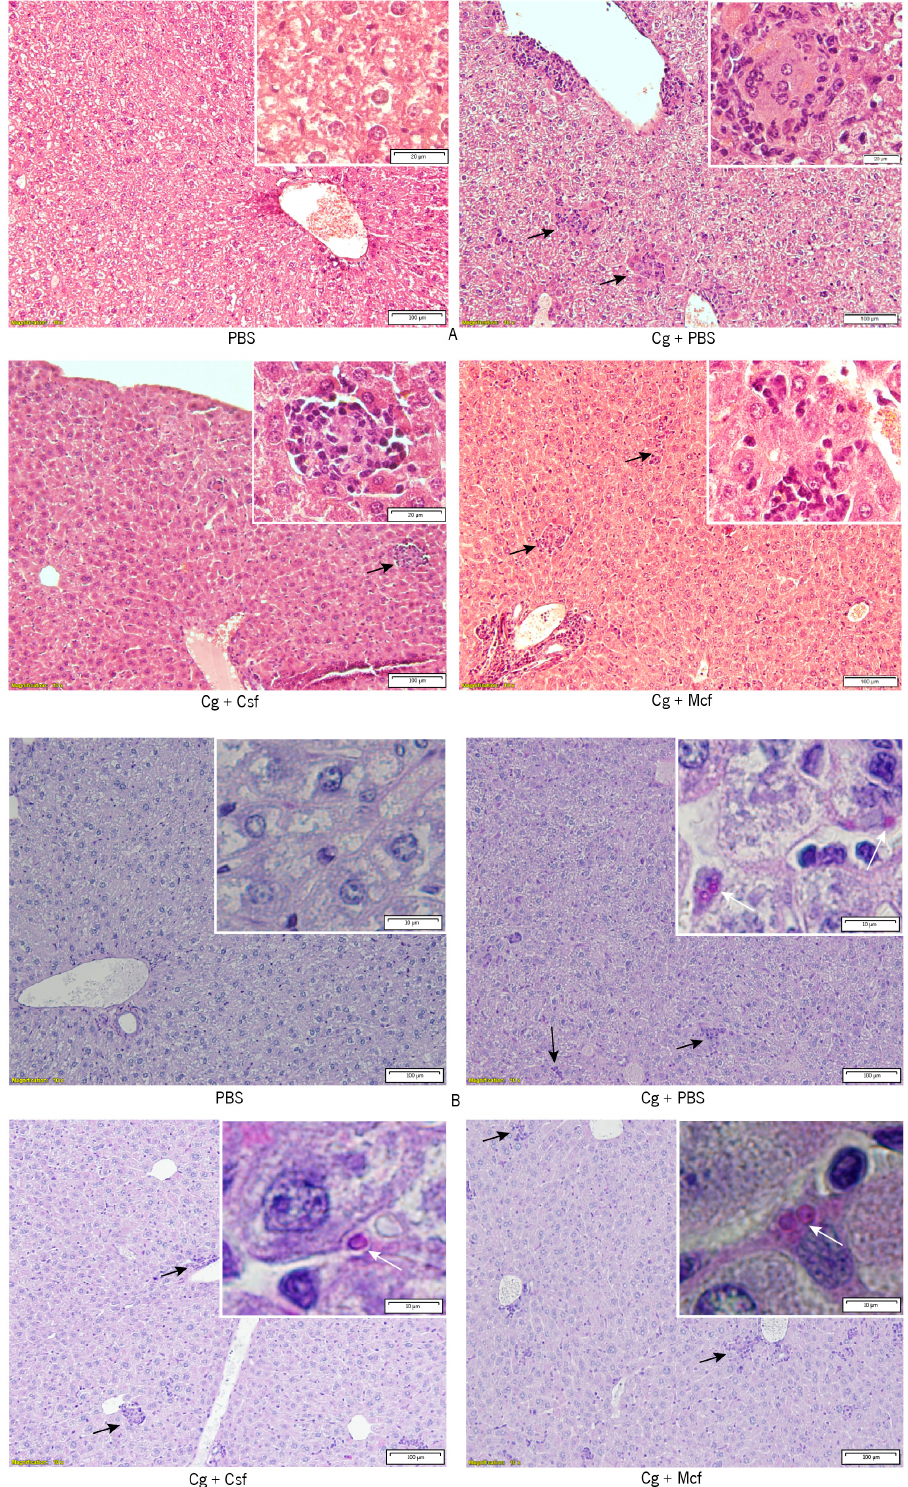
Figure 6. Analysis of liver histology in CD1 mice. ( A ) Representative hematoxylin-eosin and ( B ) periodic acid–Schiff (PAS)-stained examples of liver tissue from the indicated mouse groups. Black arrows denote inflammatory infiltrates that were mostly of the mononuclear type. Insets correspond to higher magnification micrographs. White arrows indicate PAS-stained Candida glabrata ATCC2001 cells. Scale bars are shown and apply to similar sized micrographs (100 µm) or insets (20 µm), as indicated.